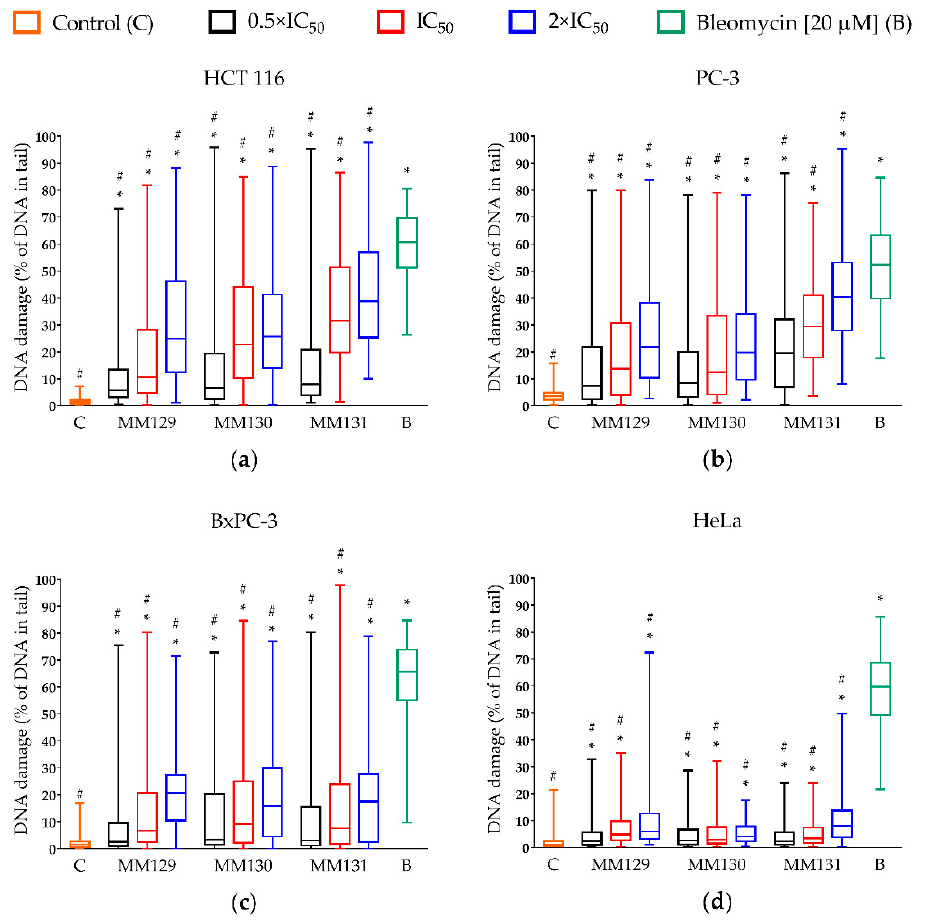
Figure 2. Evaluation of DNA damage (SSBs, DSBs, and alkali-labile sites) in human cancer cell lines: ( a ) HCT 116; ( b ) PC-3; ( c ) BxPC-3; ( d ) HeLa treated with MM129 , MM130 , and MM131 in the concentrations of 0.5, 1, and 2 × IC 50 for 24 h using the alkaline version of the comet assay. The applied concentrations of investigated compounds were at least 10 times lower than the concentration of bleomycin (positive control) used in the experiment. DNA damage was shown as a median of the percentage of DNA in comet tail with interquartile range and minimal and maximal values. Significant differences ( p < 0.0001) compared with negative (*) and positive (#) control.